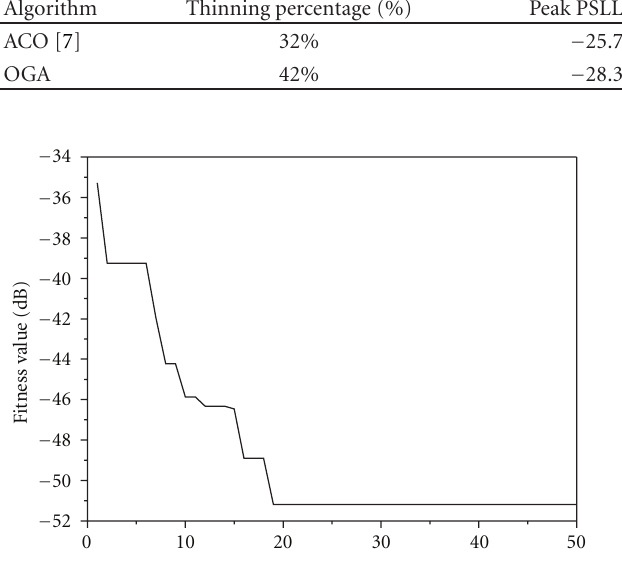
Figure 2: The convergence curve of the OGA for the planar array with the fitness function as (7).